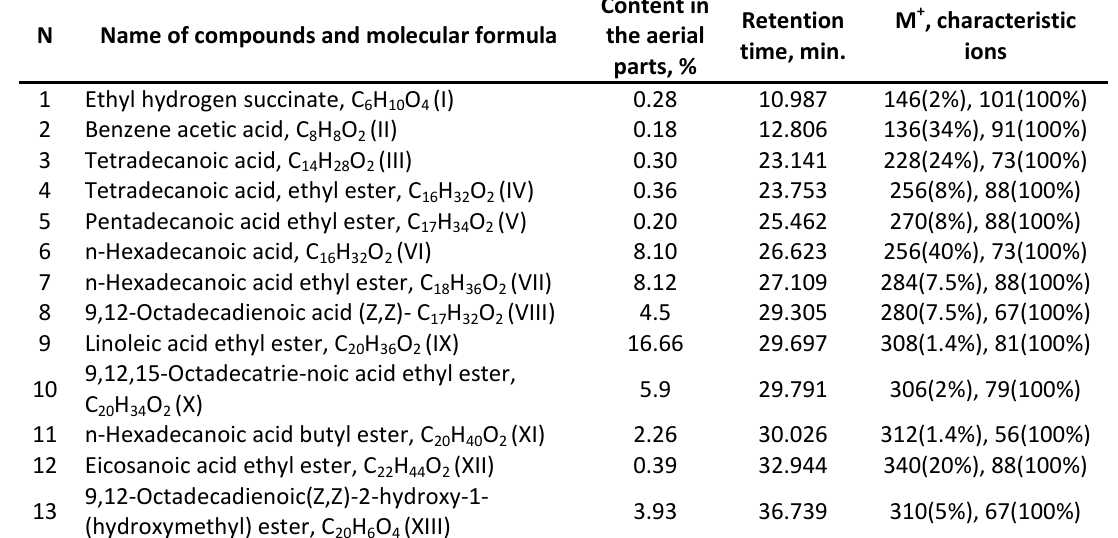
Table 1. Fatty acids and esters of aerial parts of Cicuta virosa L.